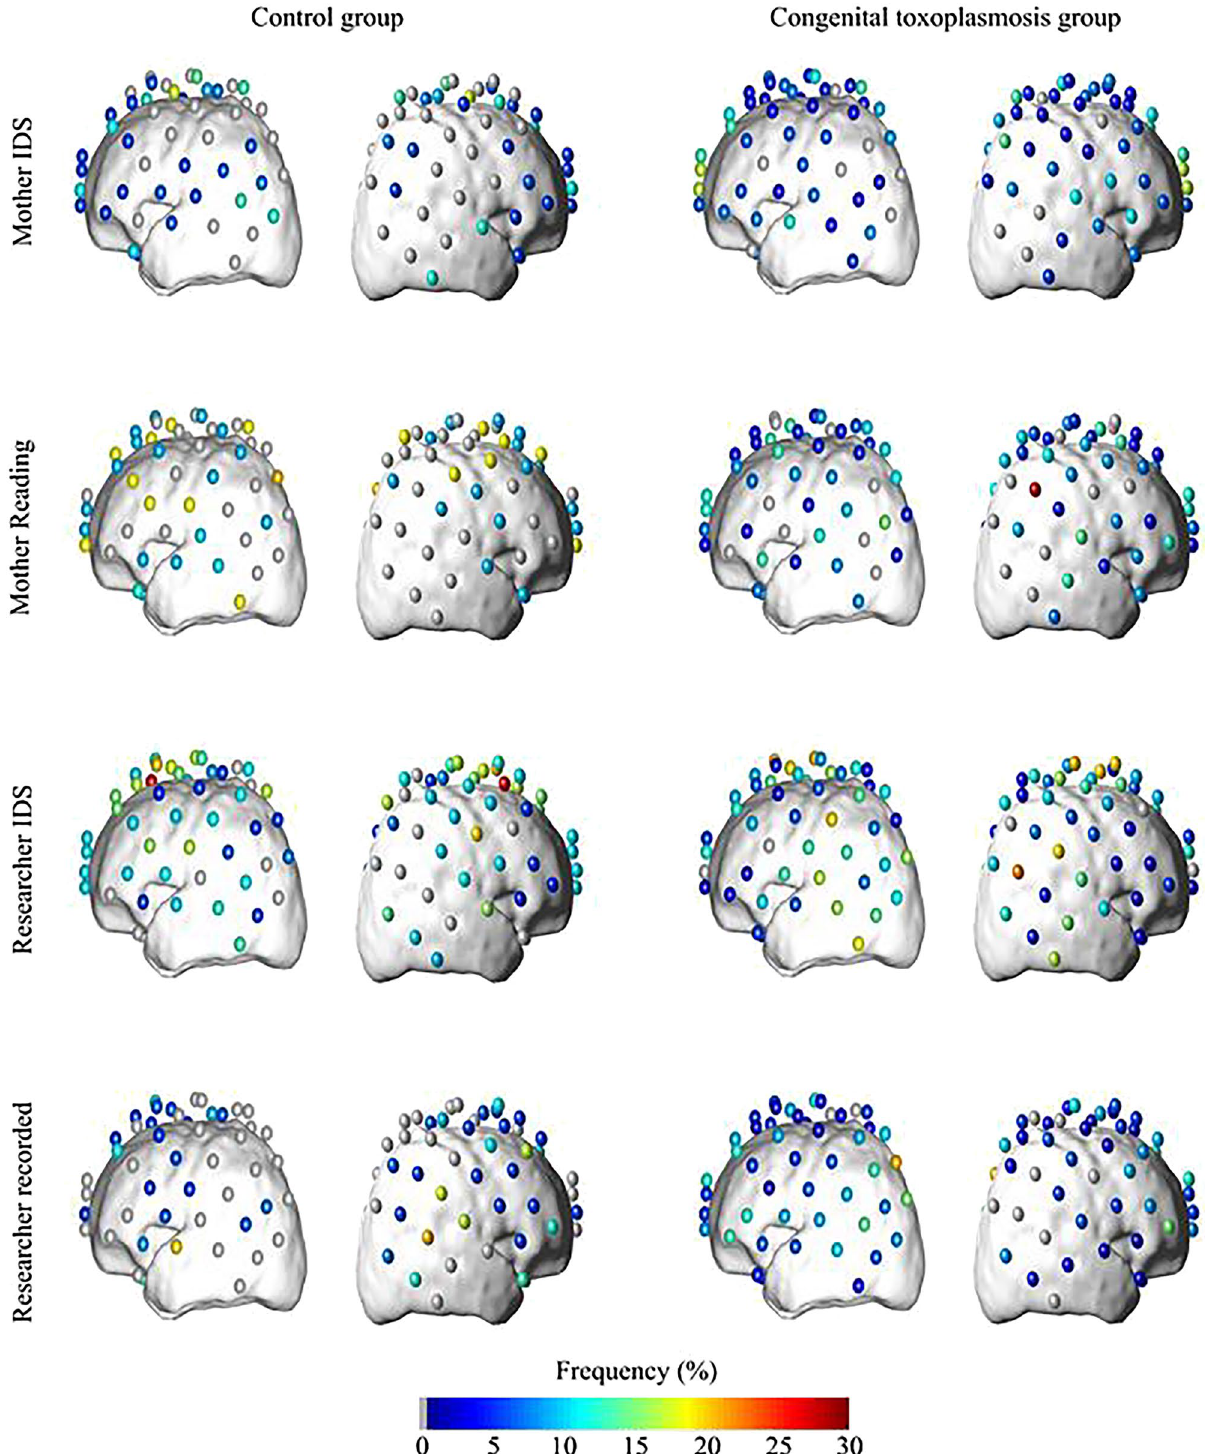
Figure 2. Frequency of activated channels in control group for: mother infant directed speech (IDS) n = 16; mother reading n = 10; researcher infant directed speech n = 17; researcher recorded n = 16; and in Congenital toxoplasmosis group for: mother infant directed speech n = 24; mother reading n = 23; researcher infant directed speech n = 27; researcher recorded n =